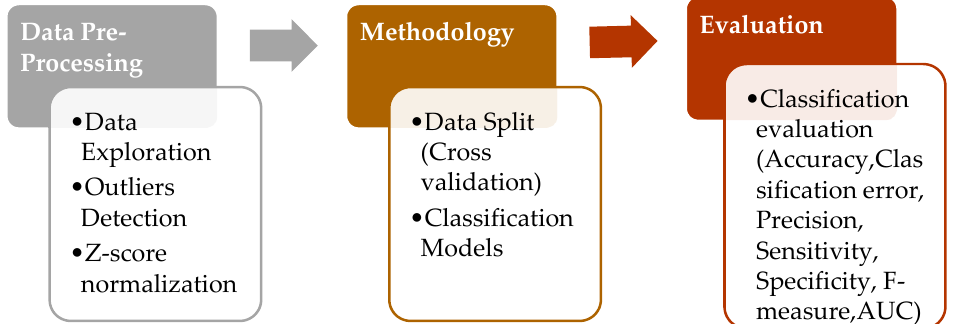
Figure 1. Methodology Flow.